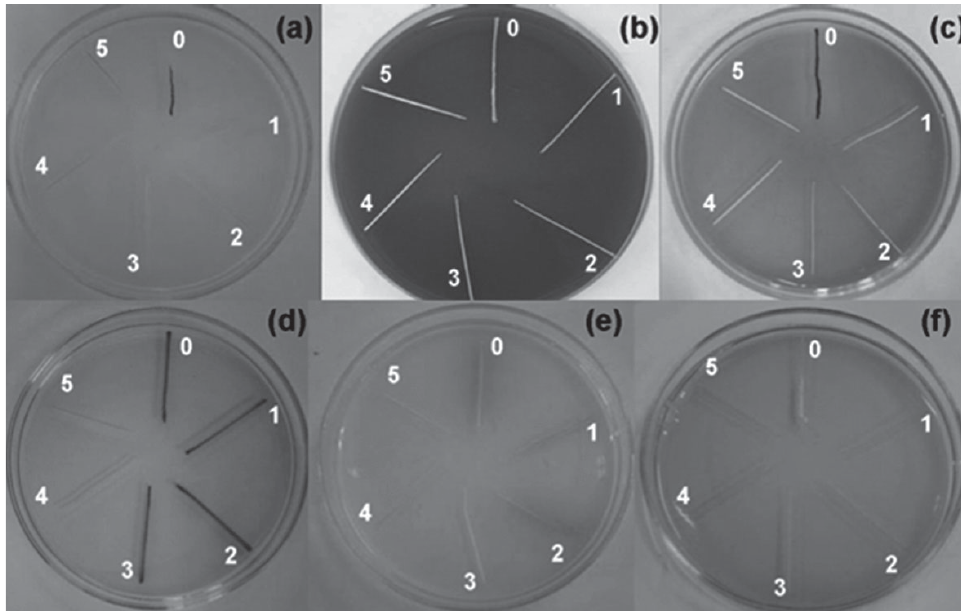
Fig. 3. Antimicrobial efficacy of 1% CHX. (A) Candida Elective Agar according to Nickerson; (B) Blood Agar; (C) Vogel and Johnson; (D) Chromocult Enterococci Agar; (E) Cetrimide; (F) Saboraud Dextrose Agar.